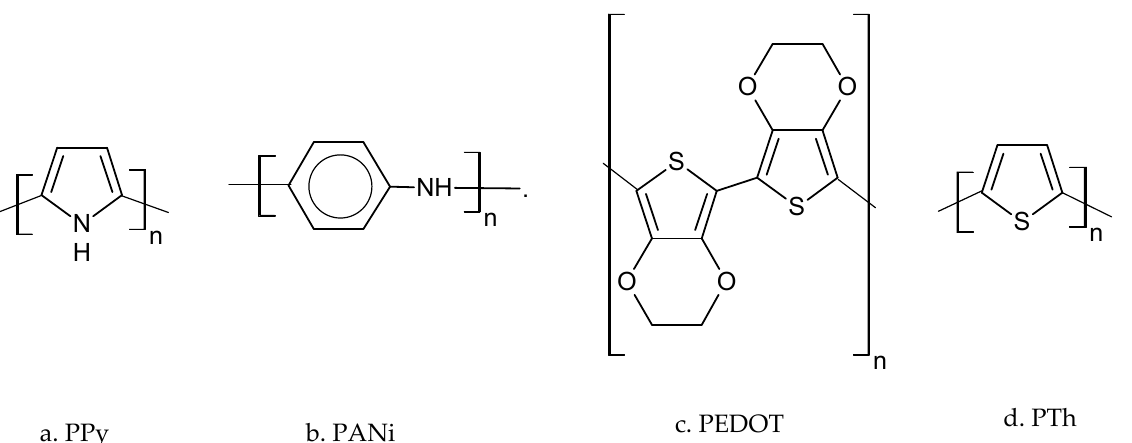
Figure 3. The most frequently used conductor polymers: ( a ) PPy, ( b ) PANI, ( c ) PEDOT, and ( d ) PTs. Adapted from [95].